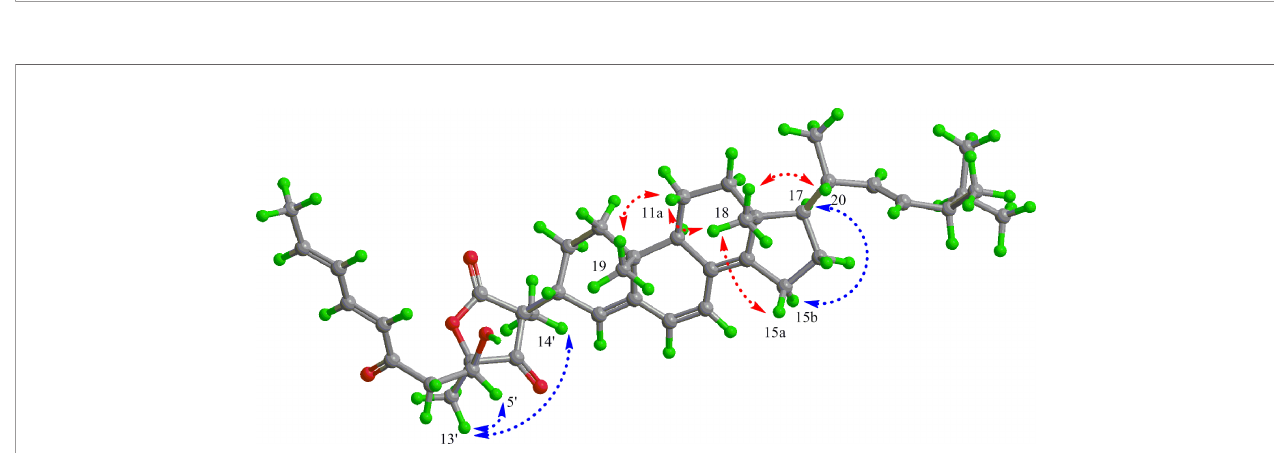
FIGURE 2 | Key 1 H- 1 H COSY (bold lines) and HMBC (red and blue arrows for intra- and inter-fragments 1A and 1B , respectively) correlations of 1 .